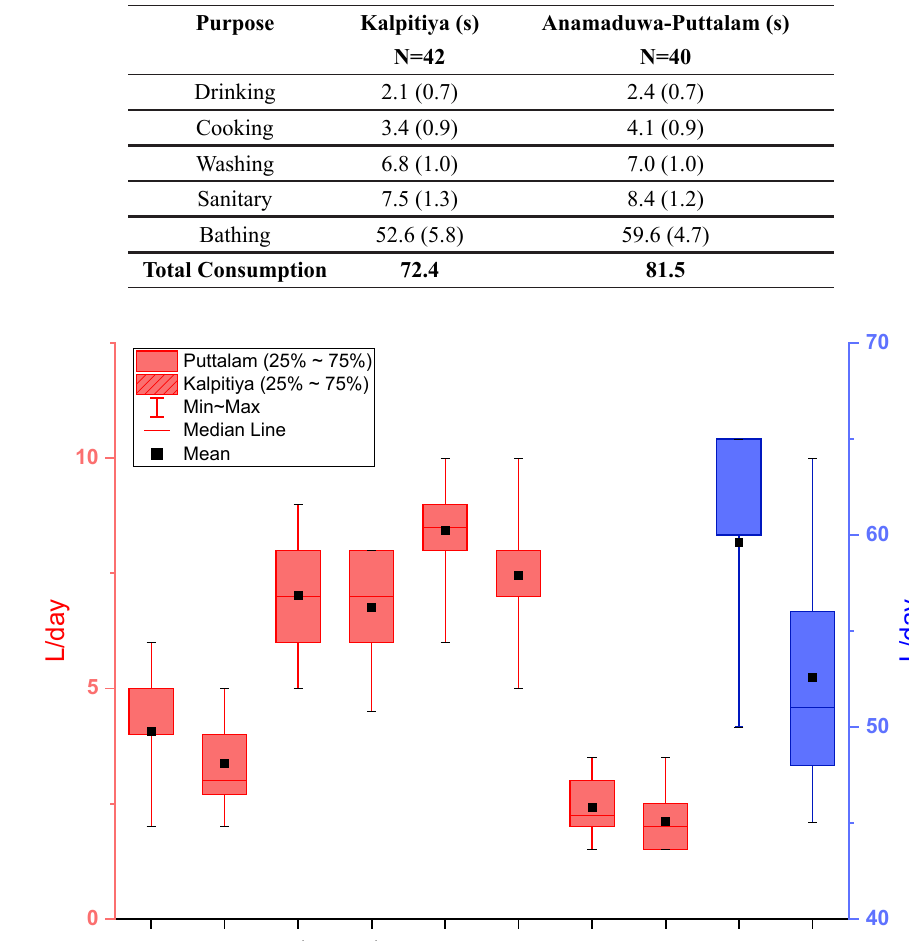
Table 1: Average domestic water consumption (L/person/day) and standard deviation (s)